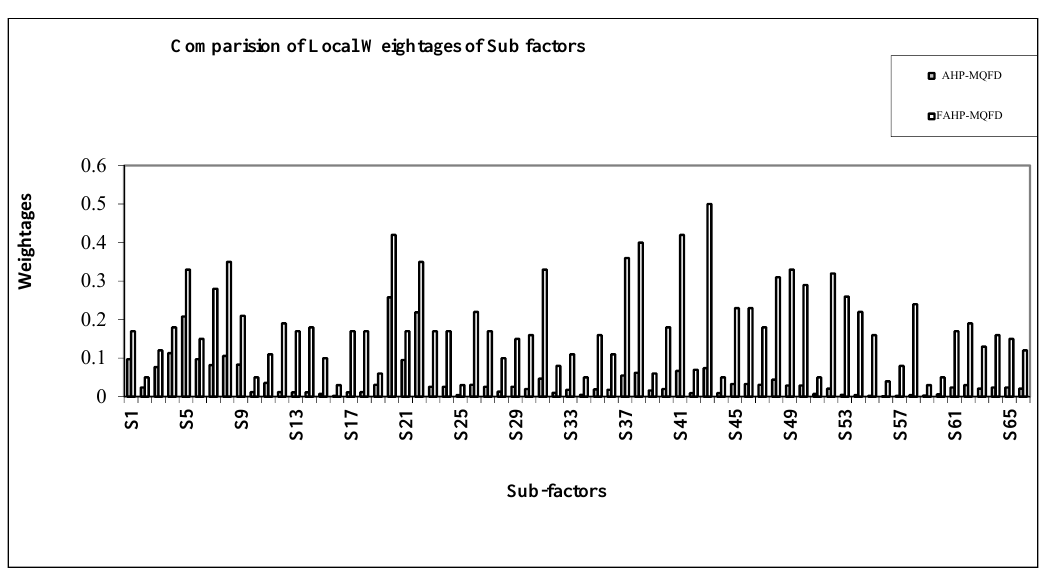
Fig. 4. Difference in global weightages of subfactors